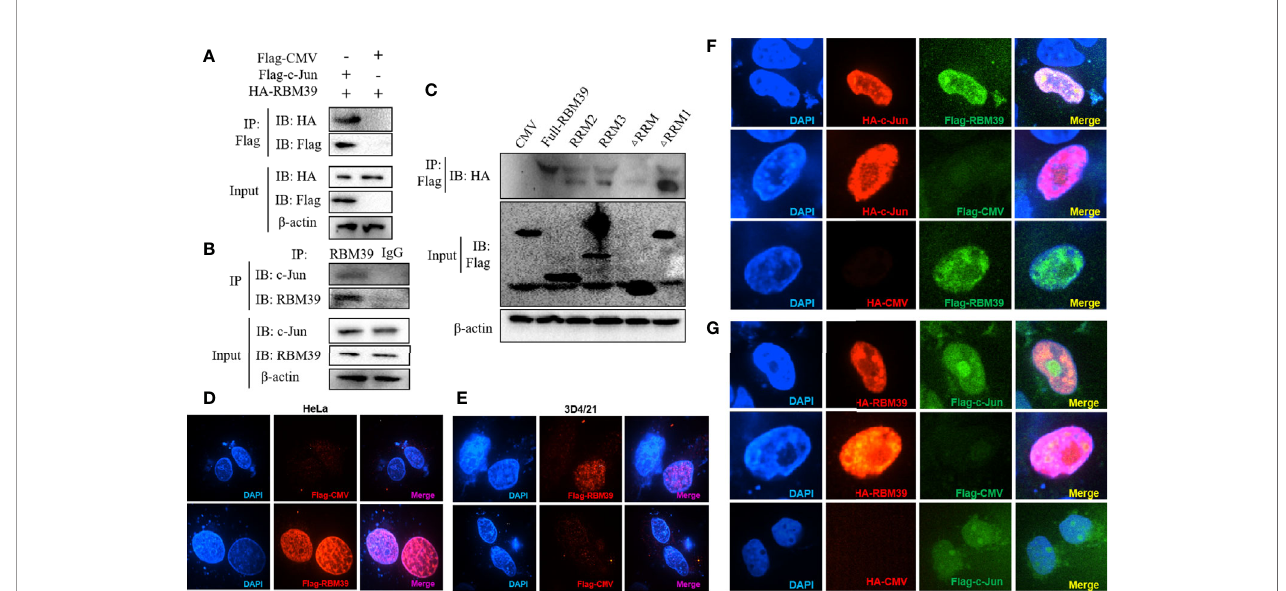
FIGURE 5 | Interaction and co-localization between RBM39 and c-Jun. Interaction between RBM39 and c-Jun in the condition of overexpressed (A) or endogenous expression (B) . (C) HEK293 cells were fi rst transfected with HA-c-Jun and then co-transfected with Flag-RBM39 (full-length), RRM2, RRM3, D RRM1, D RRM plasmid or empty vector respectively. The cell lysates were then immunoprecipitated with an anti-HA MAb and detected by Western blot at 24h post-transfection. (D – G) HEK293T cell were co-transfected with plasmid Flag-RBM39+HA-c-Jun or Flag-c-Jun+HA-RBM39 plasmid. After 24 h, cells were fi xed by 4% paraformaldehyde and doubly stained with rabbit anti-HA mAb and mouse anti-Flag antibody followed by FITC-conjugated goat anti-rabbit IgG (green) or IF555- conjugated goat anti-mouse IgG (red) antibody. Nuclei were stained with Hoechst 33258 dye (blue). Interaction and nuclear localization of RBM39 and c-Jun were observed using Laser confocal fl uorescence microscope. Data are representative of results from three independent